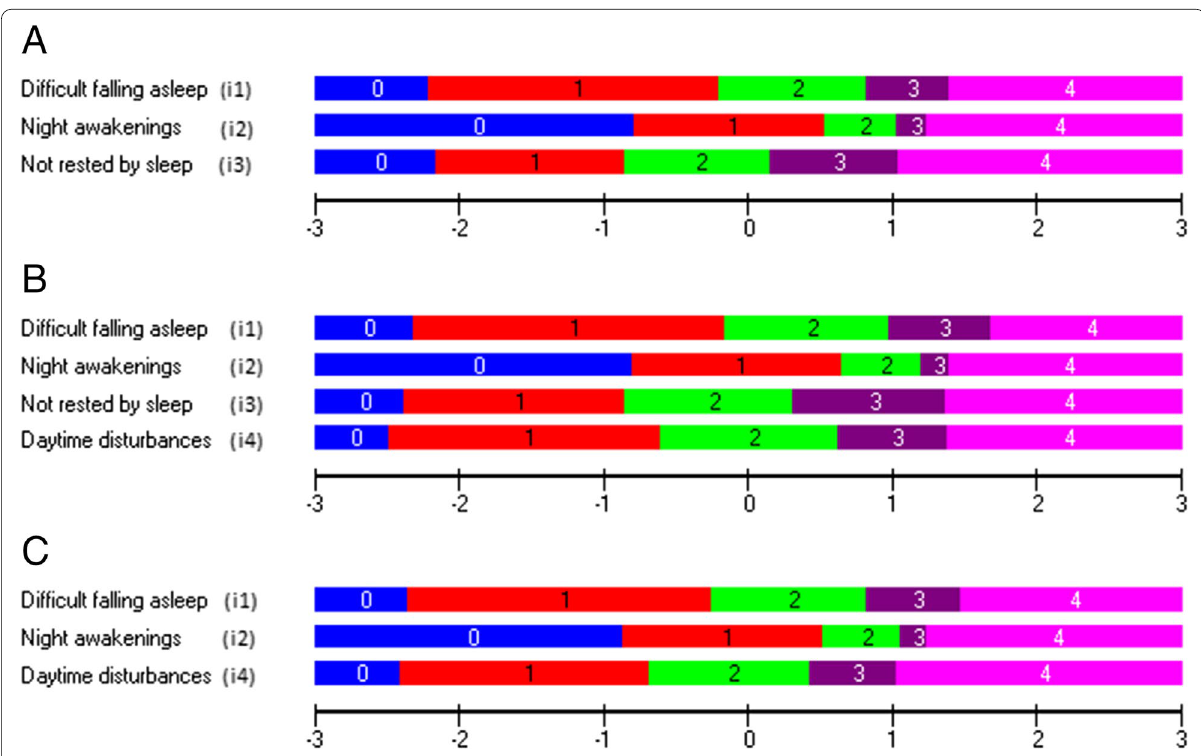
Fig. 2 Response category functioning for the Minimal Insomnia Symptom Scale (MISS; A ), the four‑item MISS ( B ), and the MISS‑Revised ( C ). Areas 0–4 correspond to the five response categories (0 severe problems), and the borders between the respective areas are the logit threshold location on the insomnia continuum (x‑axis; positive values more insomnia) where there are equal probabilities of responding in either of the adjacent response =